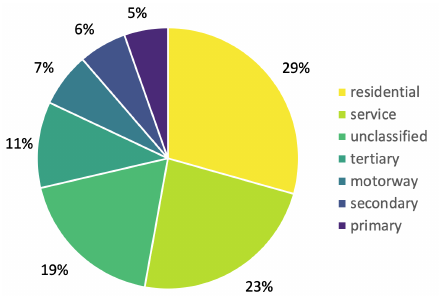
Figure 1. Distribution of the of the different types of streets in Milan, computed by